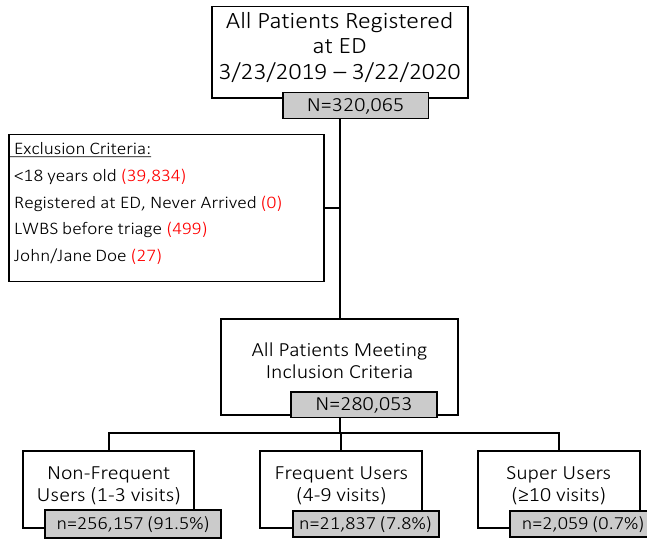
Figure 1. Flowchart outlining inclusion and exclusion criteria and methodology for assigning study participants into user groups. ED, emergency department; LWBS, left without being